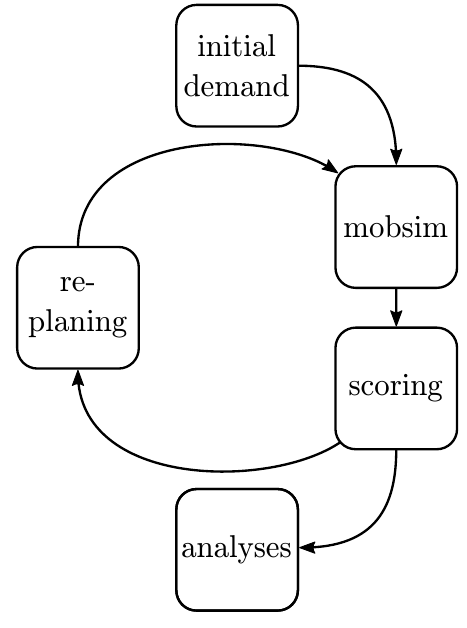
Figure 4. MATSim